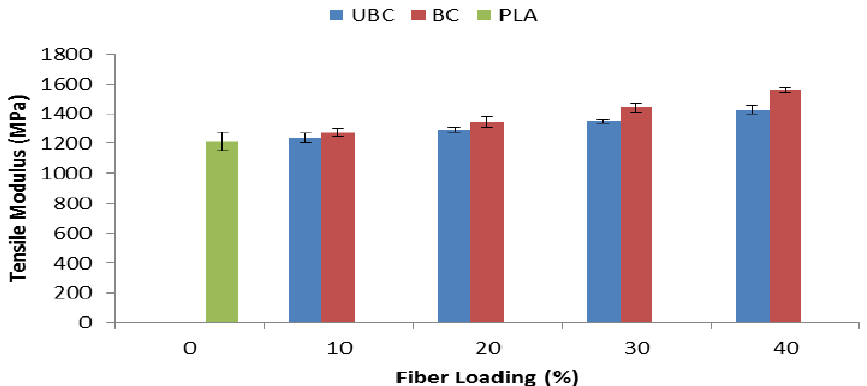
Figure 5. Tensile modulus of pure PLA, UBC and BC